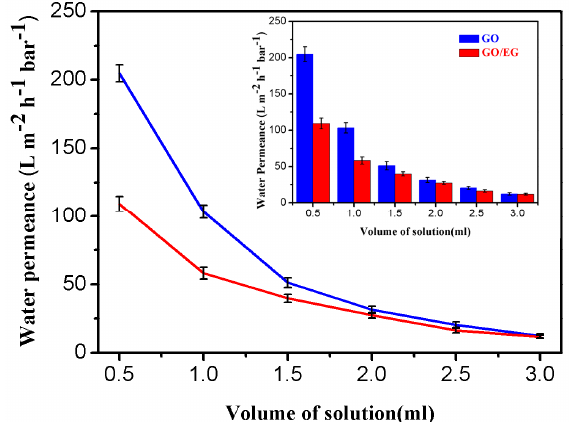
Figure 5. The water permeance of GO and GO/EG membranes, as a function of the amount of GO and EG/GO used to prepare the